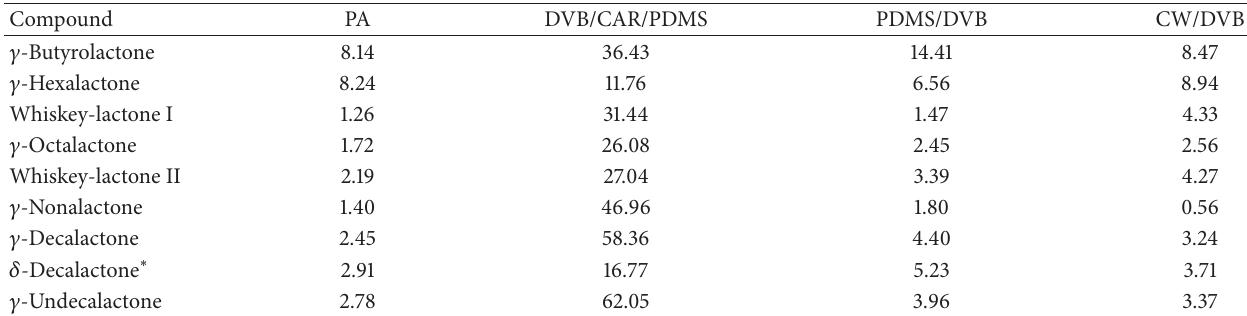
Table 3: RSD (%) ( 𝑛 = 5 ) of the relative areas of studied compounds obtained with studied fibers.